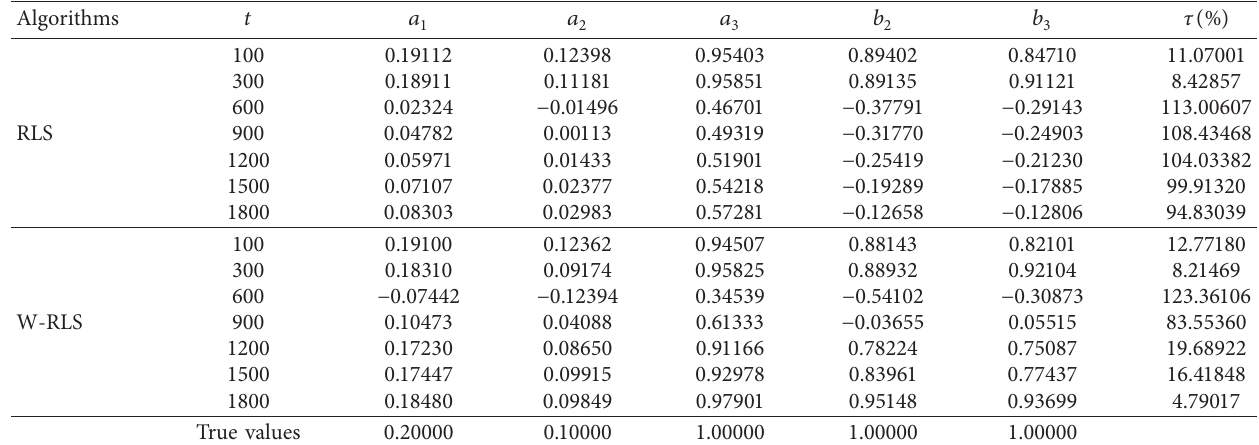
Table 2: The parameter estimates and